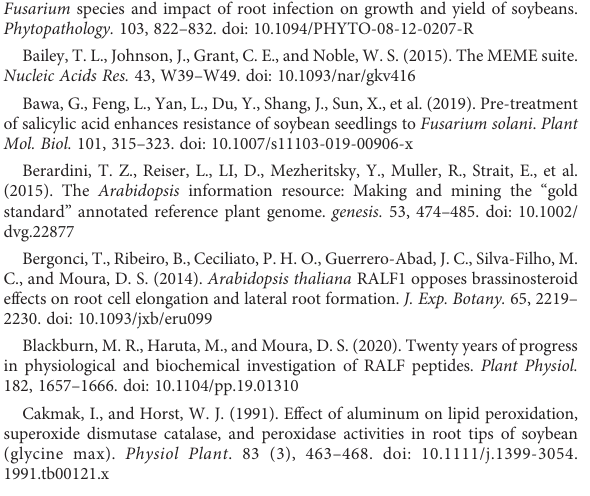
positivelyregulate the immune